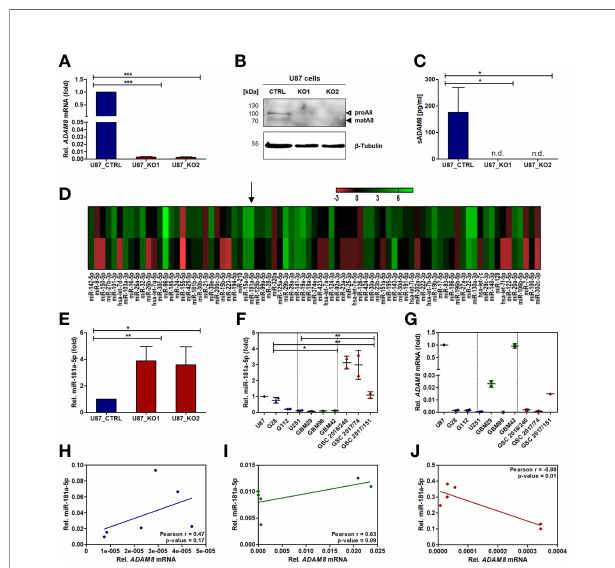
FIGURE 1 | Screening of two representative CRISPR/Cas9 ADAM8 (hA8) KO cell clones reveals an ADAM8-dependent regulation of miR-181a-5p. Con fi rmation of the CRISPR/Cas9 ADAM8 stable KO in U87 cells by qPCR (A) , Western Blot (B) , and ELISA (C) . (D) A RT-qPCR-based miRNA PCR Array (Human Finder, Qiagen) of U87 CRISPR/Cas9 ADAM8 KO cells enabling the analysis of a total of 84 miRNAs. The legend for the fold- changes in the heat map is given above representing the fold-change values (2 - DD CT ) relative to U87_CTRL cells in both ADAM8 KO clones. Note the variance in fold changes between the two KO clones (E) Con fi rmation of miR- 181a-5p upregulation in U87_KO1 and U87_KO2 cells (p-value: 0.01 and 0.03). The expression of miR-181a-5p (F) and ADAM8 (G) in GBM cell lines (G28, G112, U251), primary patient-derived cell lines (GBM29, 98, and 42), and GBM stem-like cell lines (GSCs) (GSC 2016/240, GSC 2017/74, GSC 2017/151) are shown as relative values to the expression in U87 cells. MiR- 181a-5p is mostly expressed in GSCs. The patient-derived cell line GBM42 shows the highest ADAM8 expression. Pearson correlation analysis of miR- 181a-5p and ADAM8 in cell lines (H) , primary cell lines (I) , and primary GSCs (J) reveal a negative correlation only observed in GSCs (p-value: 0.01, Pearson r: -0.88). Results are given as mean +/- SD of two to three independent experiments. Unpaired two-tailed students t-test or two way ANOVA for multiple comparison (F) were applied to determine signi fi cance: *p < 0.05, **p < 0.01, ***p < 0.001. n.d., not